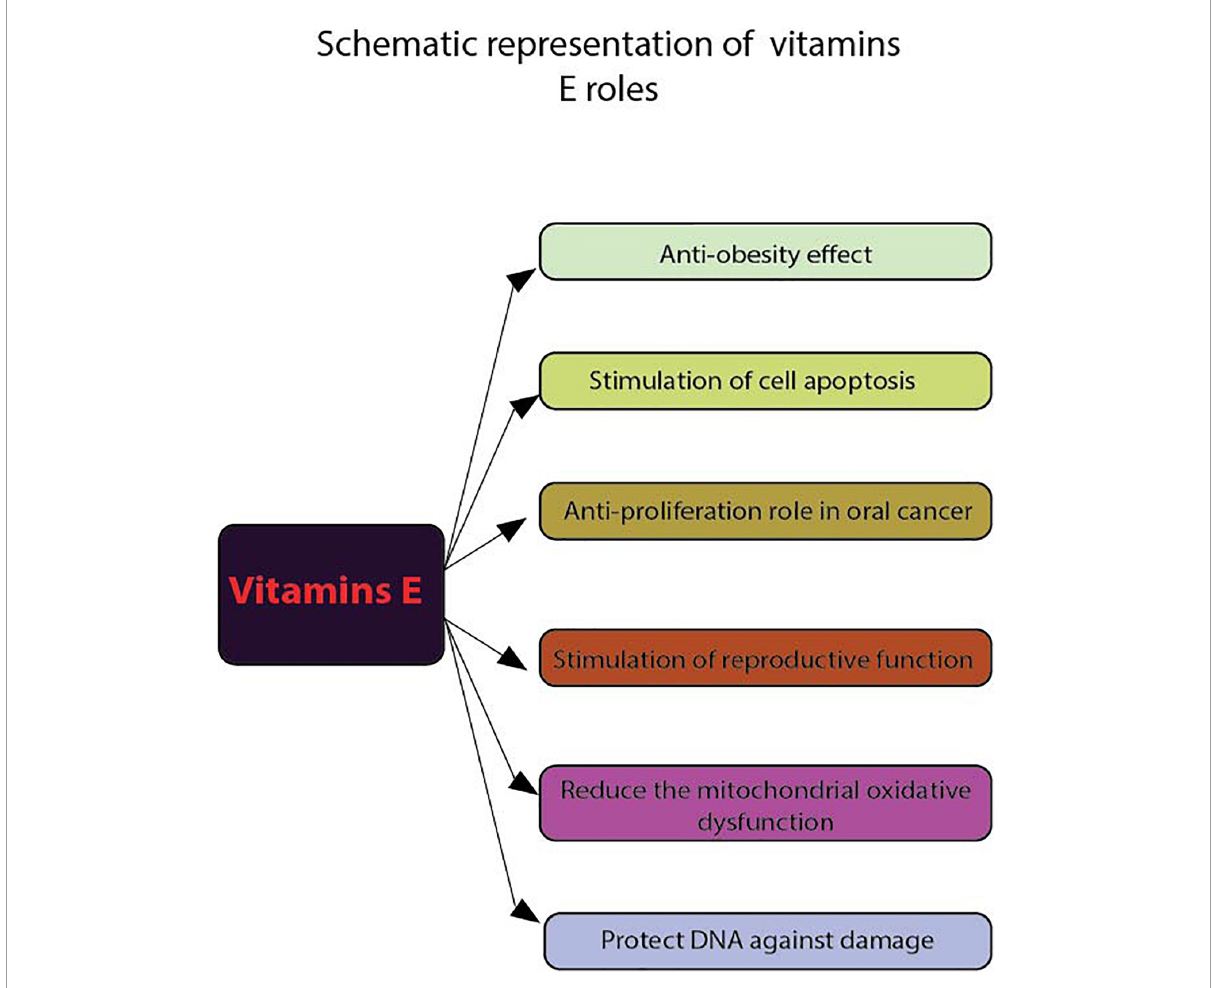
FIGURE1 Schematic representation of vitamins E roles. Using flow cytometry, the following functions of vitamins E were highlighted: anti-obesity effect, stimulate cell apoptosis, anti-proliferation role in cancer, stimulate reproductive function, reduce the mitochondrial oxidative dysfunction and protect DNA against